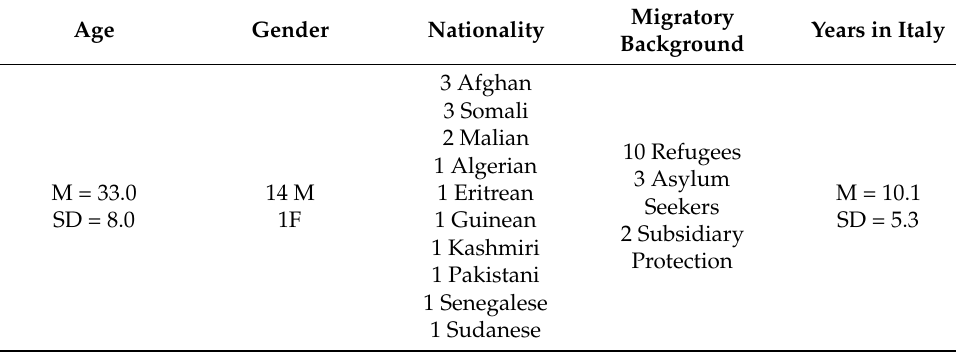
Table 1. Participant